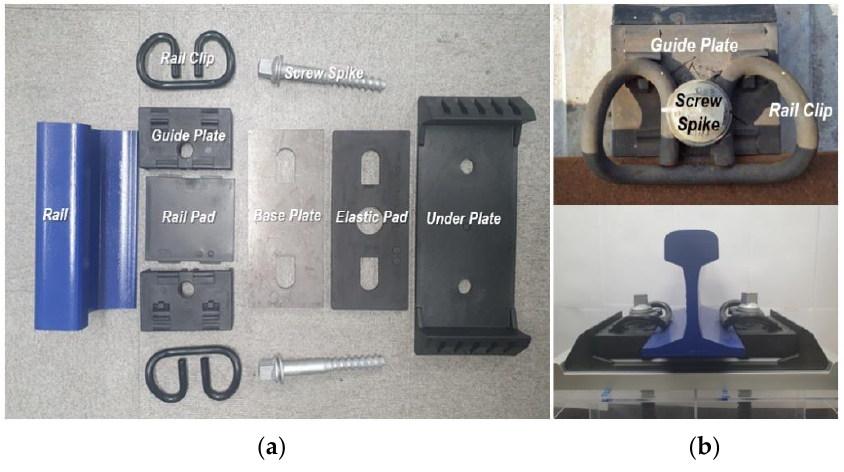
Figure 1. Damaged rail clip.